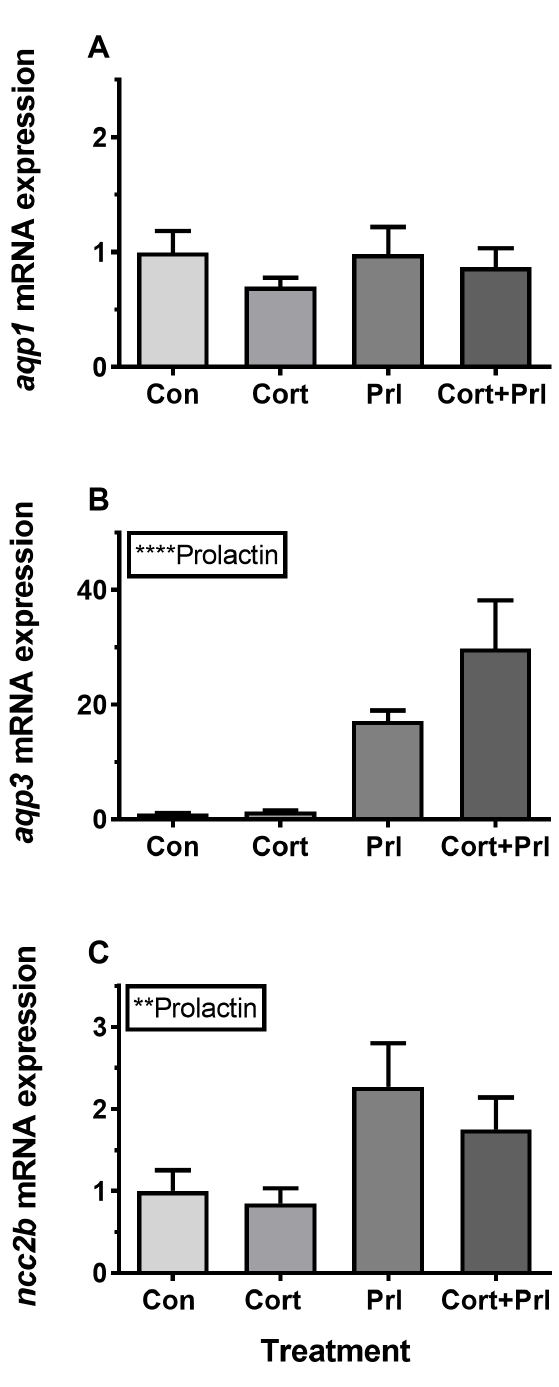
Figure 13. ( A – C ) Ex vivo e ff ect of cortisol (10 µ g mL − 1 ), ovine PRL (1 µ g mL -1 ), and their combination on AQP1 , AQP3 , and NCC2b expression in FW medaka gills. Gill explants were incubated for 18 h at room temperature. Expression of each target was normalized to the geometric mean of the three normalization genes: EF1a , bact , and RPL7. Data are presented as mean ± standard error of the mean (n = 7–8). Statistically significant overall e ff ects of prolactin (two-way ANOVA, P < 0.05) are denoted by asterisks: ** P < 0.01, **** P < 0.0001. No significant interaction between cortisol and prolactin factor was found, and post-hoc tests were therefore